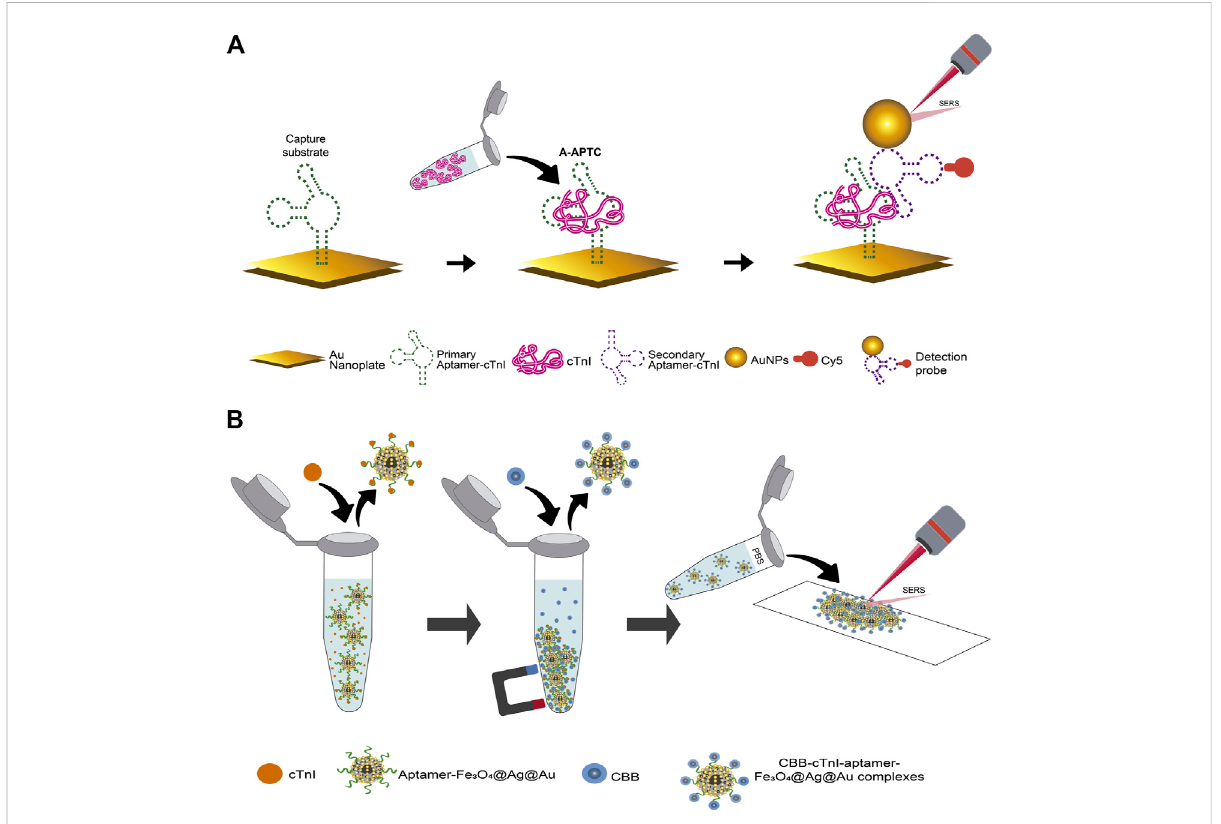
FIGURE 9 Schematicrepresentationofaptamer-basedSERSassaysforcTnI: (A) thesandwichassayusinganatomically fl atAunanoplateastheplasmonic substrate, adapted from Lee et al. (2020), (B) assay using the Bradford method, adapted from Lin et al.